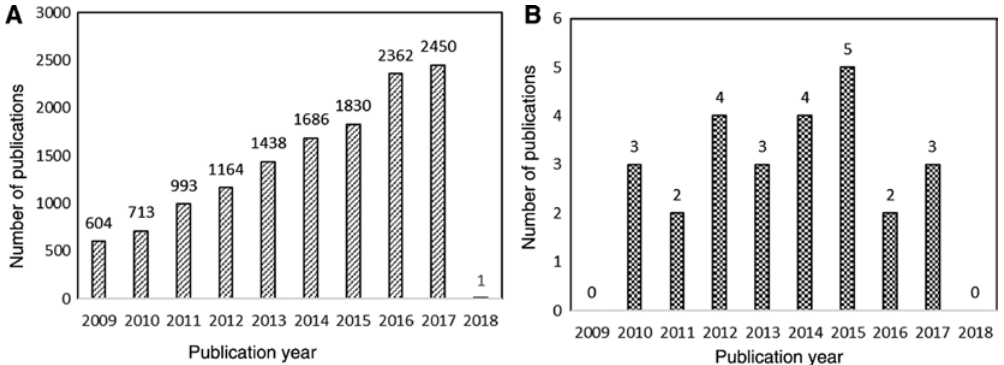
Figure 2: (A) Number of scientific publications contributing to the subject “MNPs AND biomedical applications” and (B) “NiCu NPs AND biomedical applications” by publication year. Search done through ScienceDirect on 19 July